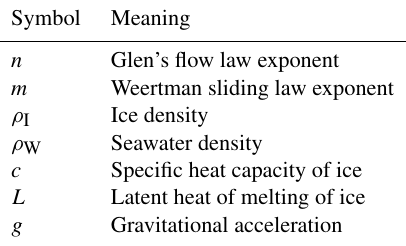
Table A2. Physical